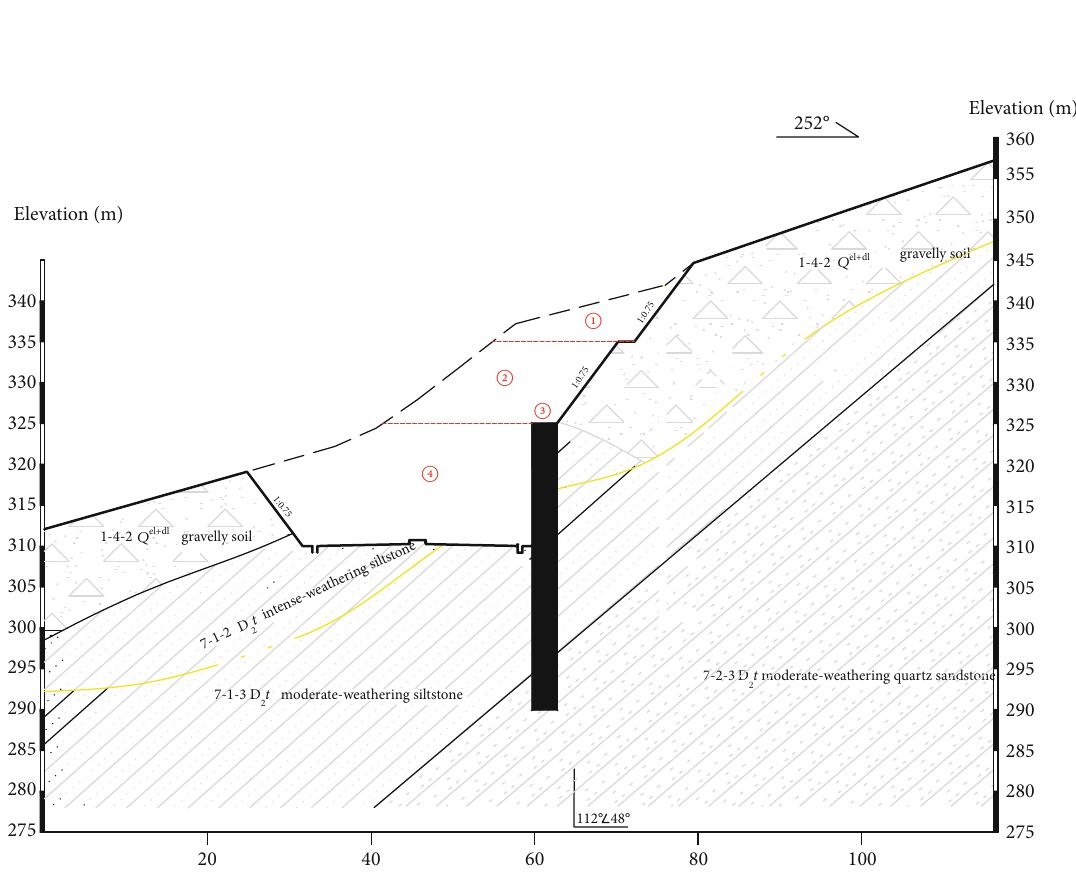
Figure 6: Actual construction